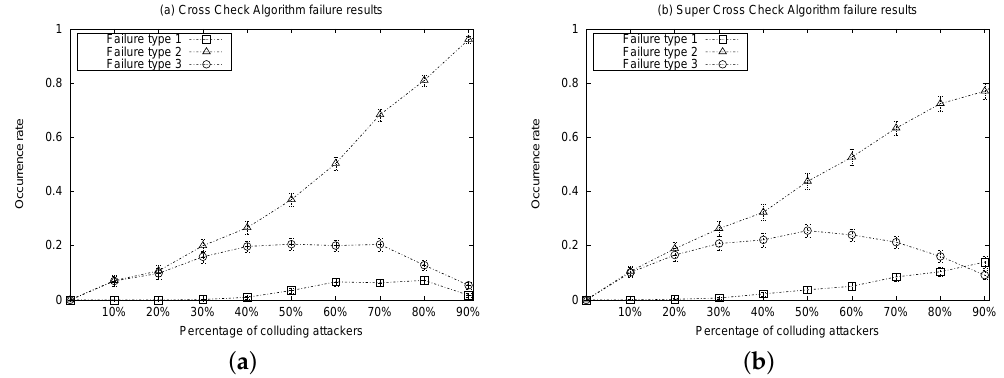
Figure 6. Comparison of colluder detection failures in the uniformly deployed WSN simulations. Failure type 1 refers to a final CC list that is empty. Failure type 2 refers to a non-empty final CC list containing, at least, one attacker. Failure type 3 means a non-empty final CC list containing exactly one attacker. ( a ) CC algorithm; ( b ) super cross-check